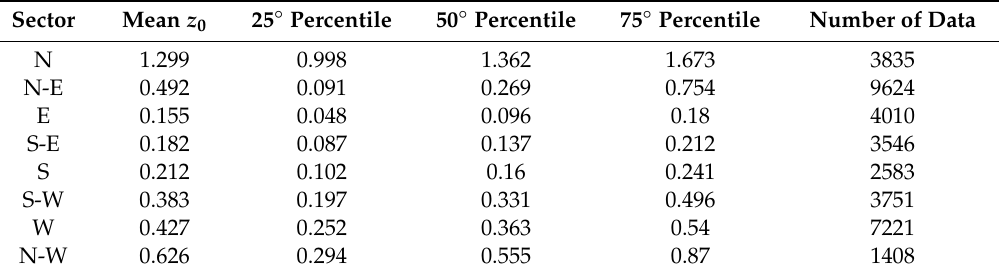
Table 10. Surface roughness z 0 for